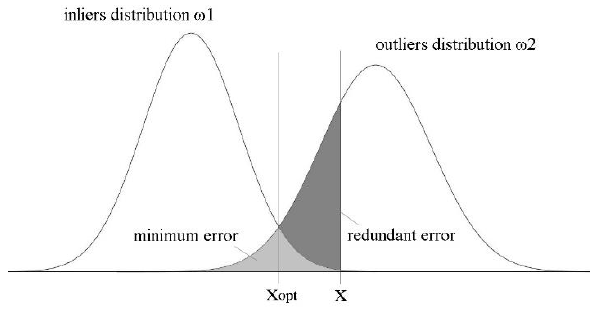
Figure 1. One-dimensional classification error